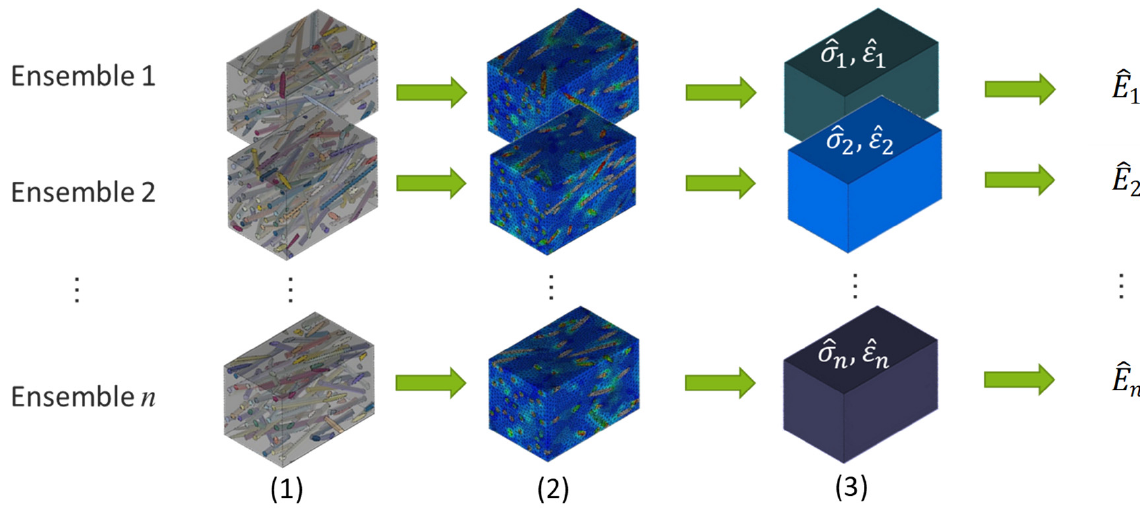
Figure 3. Method of homogenization: creation of the microstructure (1), use of FEM to determine local stresses and strains (2), volume averaging (3) and calculation of effective modulus (4).